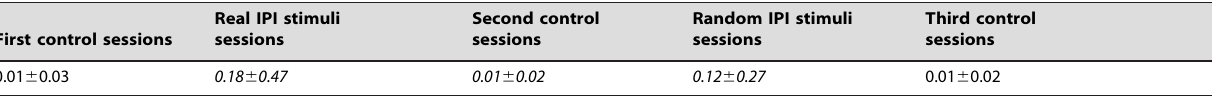
Mean% 6 StD cessation of firing